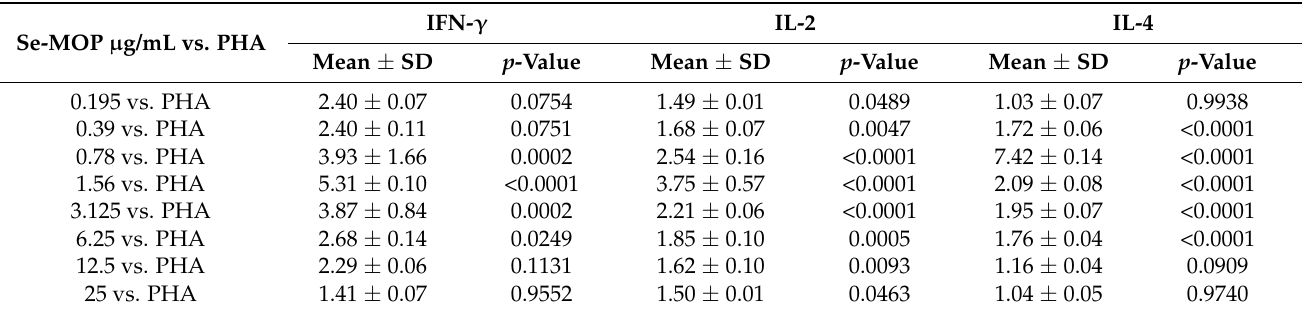
Figure 7. The lymphocyte proliferation of every group in single stimulation of Se-MOP or MOP and in synergistic stimulation of Se-MOP or MOP with PHA or LPS after 48 h ( A ). The changes in cytokine content of lymphocytes in each group in synergistic stimulation of Se-MOP with PHA after 48 h ( B ). ( A ) The viability rate of Se-MOP and MOP (0.195, 0.39, 0.78, 1.56, 3.125, 6.25, 12.5, 25, 50, 100, 200 μ g/mL) on lymphocytes in single stimulation and in synergistic stimulation of Se-MOP or MOP with PHA (10 μ g/mL), LPS (5 μ g/mL) after 48 h. Data from five separate experiments are expressed as means ± SD in triplicate. ( B ) The relative RNA expression of lymphocyte IFN- γ , IL-2, and IL-4 contents in each group in synergistic stimulation of Se-MOP (0.195, 0.39, 0.78, 1.56, 3.125, 6.25, 12.5, 25 μ g/mL) with PHA (10 μ g/mL) after 48 h. Data from three separate experiments are expressed as means ± SD in triplicate. * p < 0.05, ** p < 0.01, *** p < 0.001, **** p < 0.0001 vs. the control group. Table 2. The relative RNA expression of lymphocyte IFN- γ , IL-2, and IL-4 contents with p -value in each group in synergistic stimulation of Se-MOP (0.195, 0.39, 0.78, 1.56, 3.125, 6.25, 12.5, 25 µ g/mL) compared with PHA (10 µ g/mL) after 48 h. Data from three separate experiments are expressed as means ± SD in